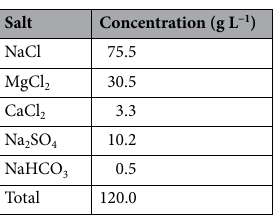
Table 1. Mass concentration of different salts in simulated saline